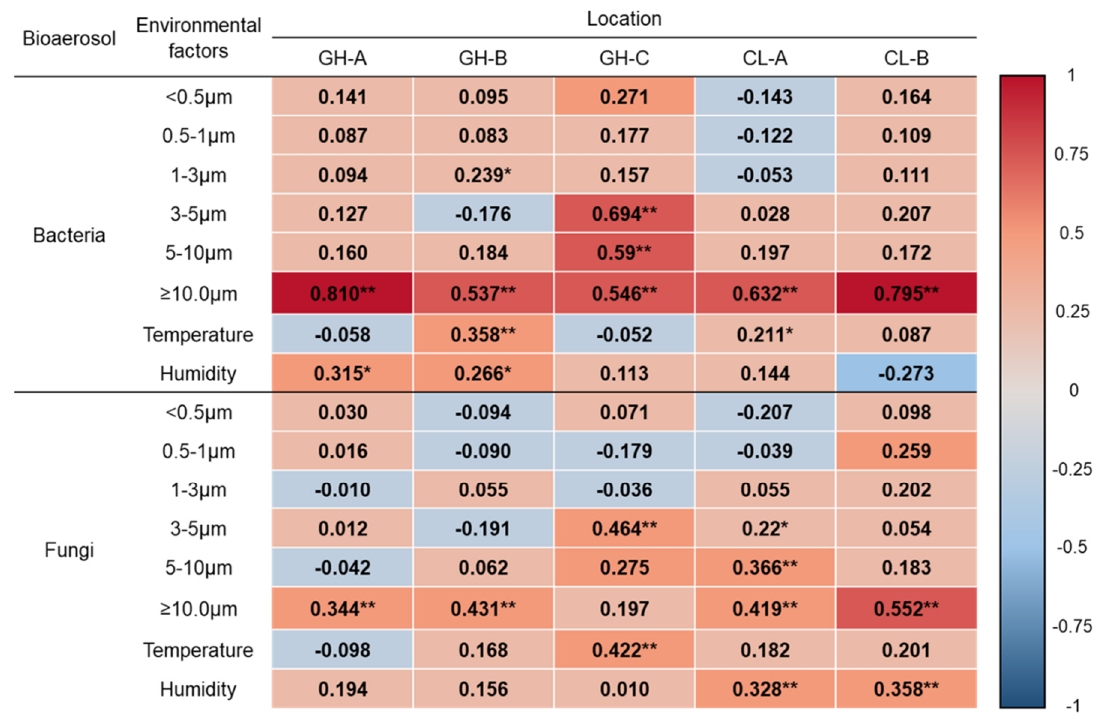
Figure 2. Pearson’s correlation coefficient matrix between bioaerosol levels and different particle sizes and meteorological conditions. * p < 0.05, ** p < 0.001.